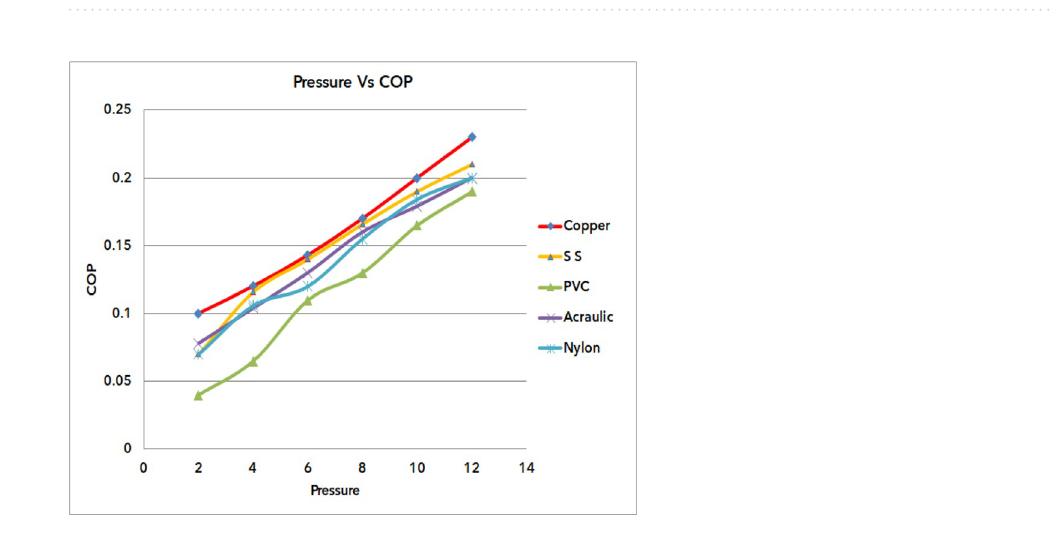
Figure 70. Pressure vs